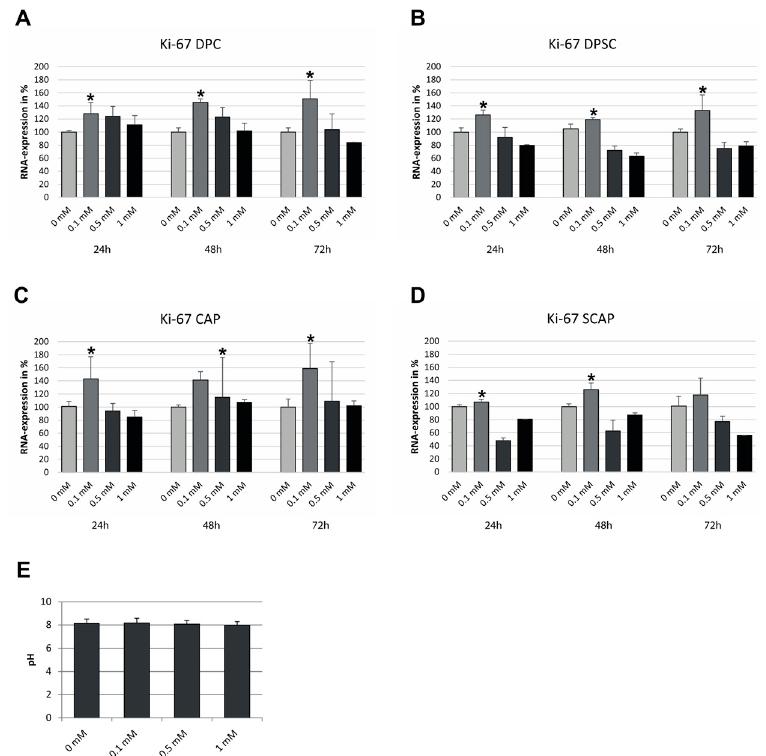
Figure 2. Proliferation of the cells after treatment with different concentrations of AA, based on the expression of Ki-67. DPC ( A ), ( B ) DPSC, ( C ) CAP, and ( D ) SCAP were treated with 0.1 mM, 0.5 mM, and 1 mM AA for 24 h, 48 h, and 72 h, and subjected for Ki-67 analyses. ( E ) Measurement of pH with indicated AA concentrations. Means ± SD of three independent experiments; * p < 0.05 indicates statistical significance vs. 0 mM.